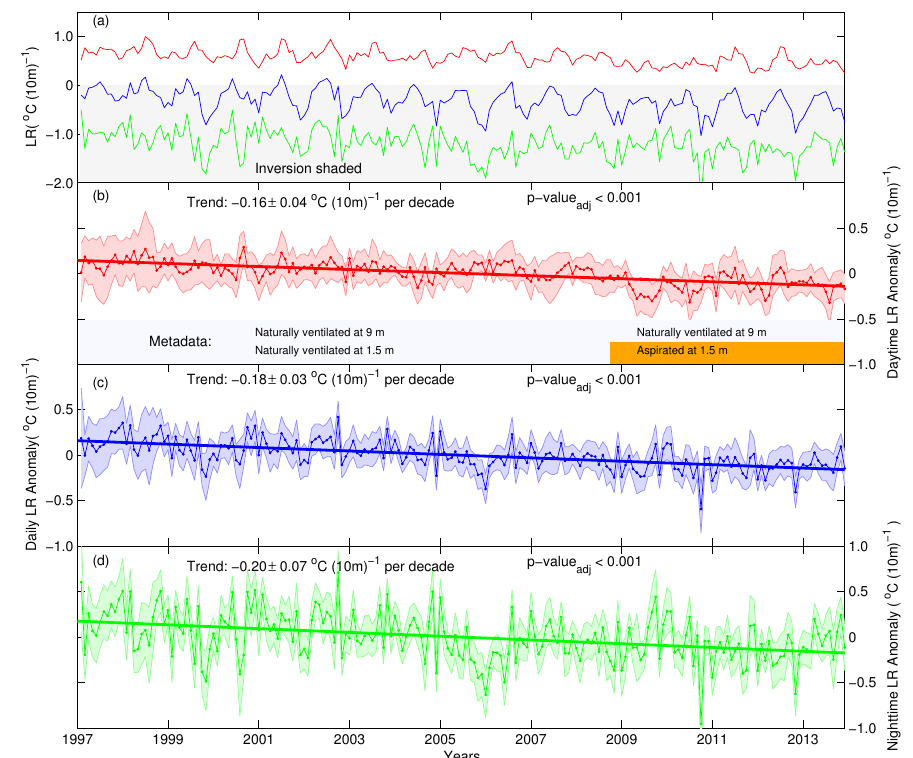
Figure 3. Changes of monthly lapse rate (LR) ( ◦ C (10m) − 1 ) in Oklahoma over 1997–2013: (a) absolute daily (blue), daytime (red), and nighttime (green) lapse rates, (b) daytime anomaly lapse rates, (c) daily anomaly lapse rates derived from 24h averaged over two heights, and (d) nighttime anomaly lapse rates. The straight lines are least squares trends ( ◦ C (10m) − 1 per decade) with adjusted p values shown. The ± values define the 95% confidence intervals for trends. The shaded region around lapse rate anomalies shows the standard deviation of 44 Oklahoma Mesonet stations. The metadata for dates of thermometer status are shown at the bottom of (b) for changes of thermometer radiation shields at 9 and